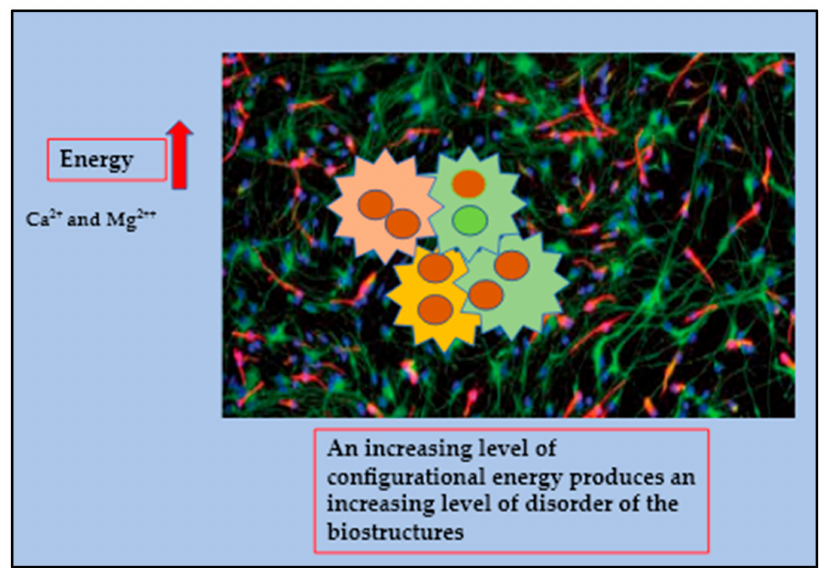
Figure 4. The cancer microenvironment is depicted as chaotic system characterized by an extremely high consumption of energy which in turns produces an increasing level of disorder of the biostruc- tures which is reflected by the huge amount of Ca 2+ and Mg 2++ accumulated within the cancer intracellular